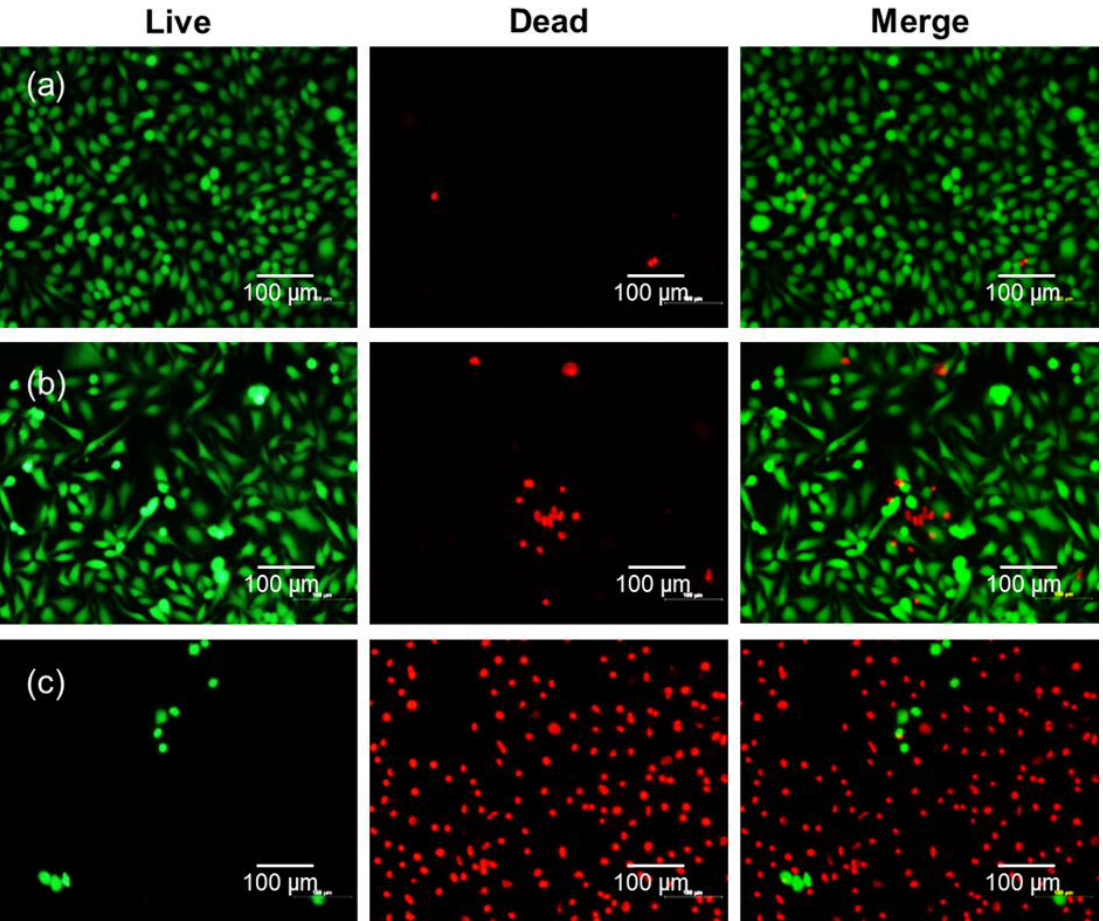
Figure 8. Fluorescence microscopy images of live HeLa cells and dead HeLa cells stained with calcein-AM (green) and ethidium homodimer-1 (EthD-1) (red) with ( a ) no drug, ( b ) free Ce6, and ( c ) DC (4 μg/mL Ce6) after irradiation by 2.5 J/cm 2 , 671 nm diode laser.